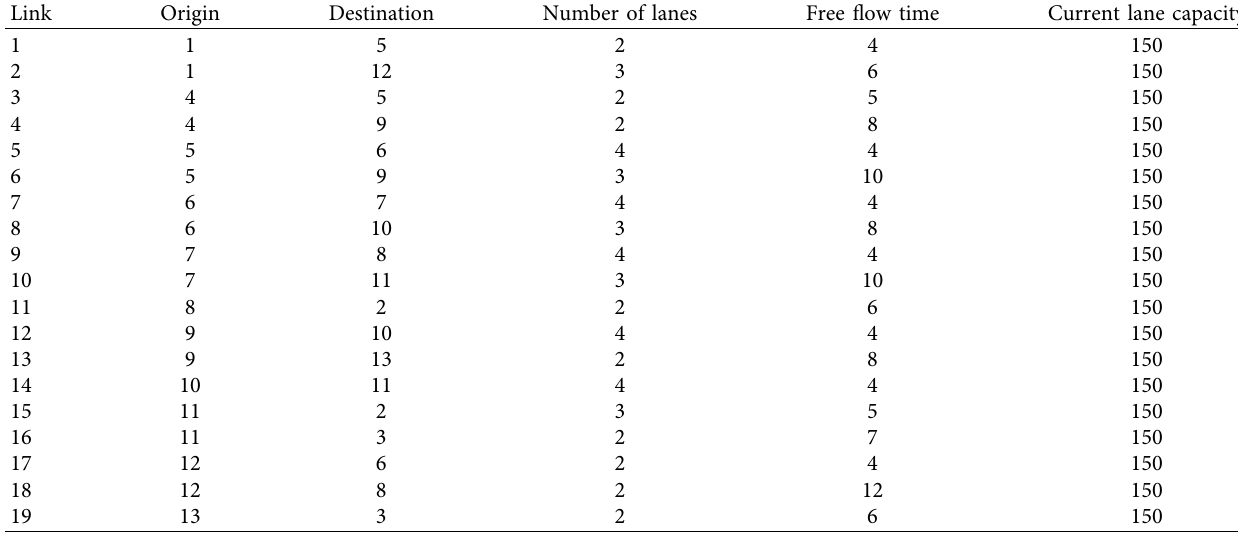
Table 2: Parameters of the Nguyen–Dupuis network.